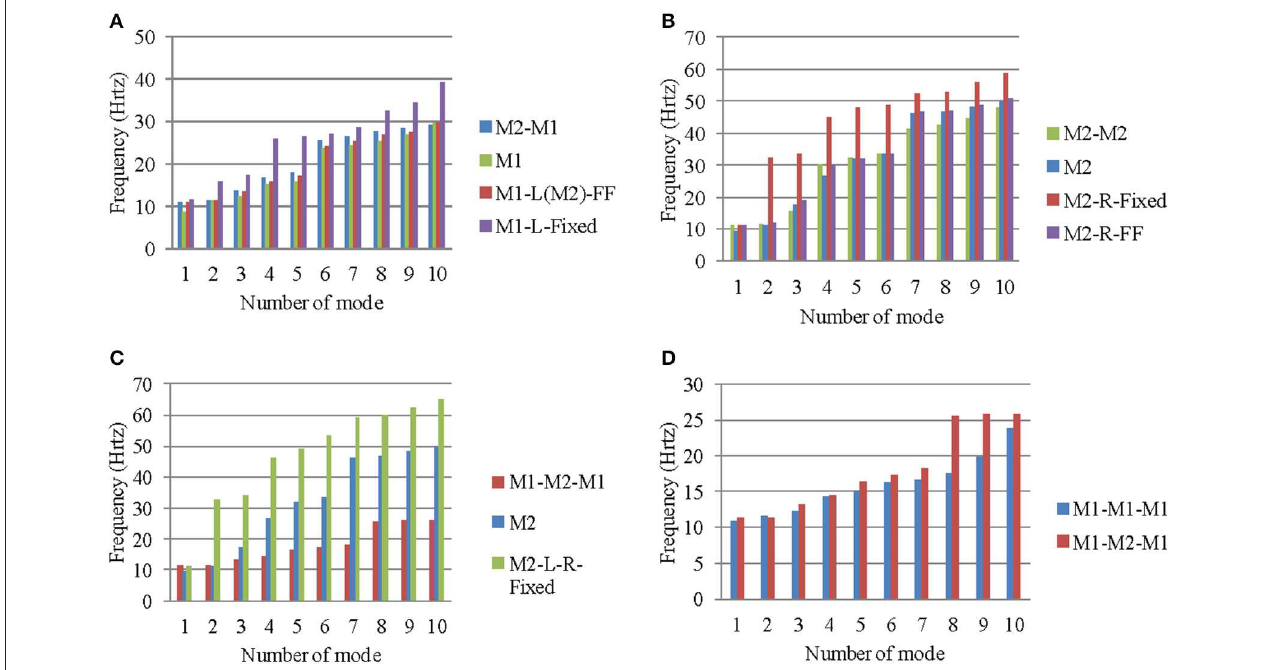
FIGURE 9 | Variation of frequencies of models: (A) M2-M1, (B) M2-M2, (C) M1-M2-M1 and the relevant boundary assumptions, and (D) M1-M1-M1 and M1-M2-M1.